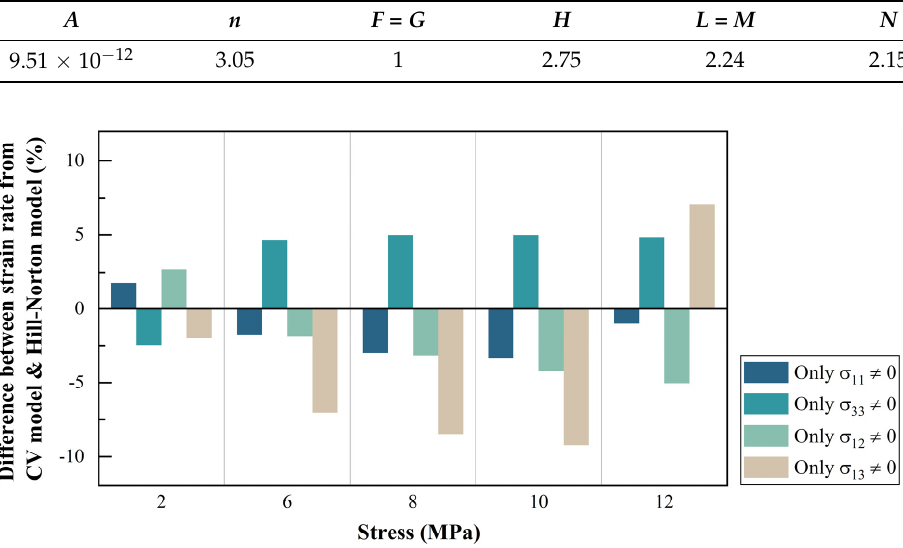
Figure 3. Percentage difference in strain rates along the loading directions obtained from the CV model and Hill–Norton formula in the low stress region.